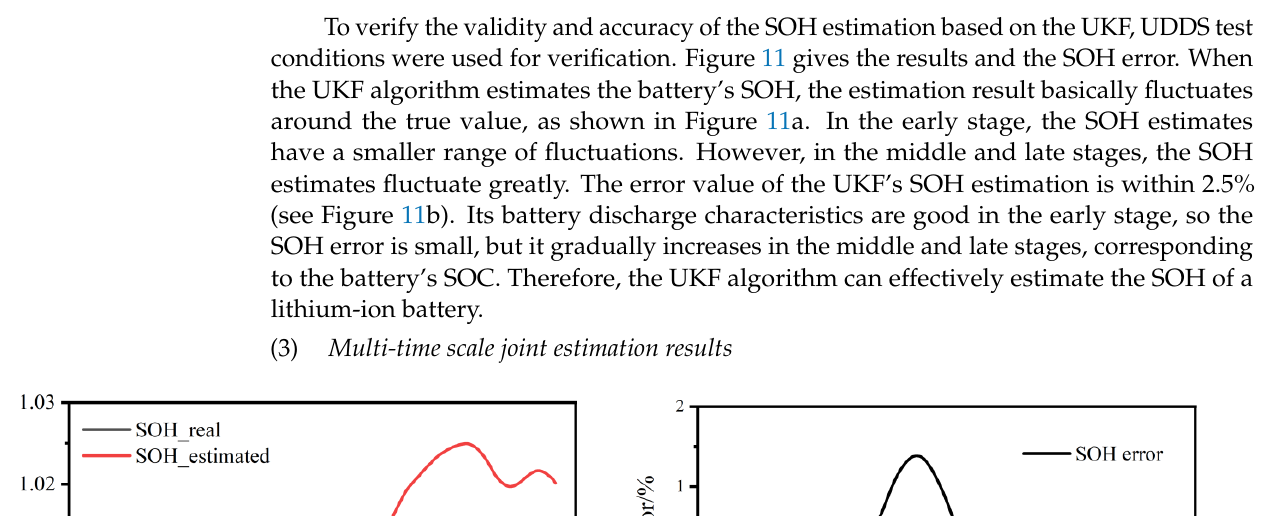
Figure 10. Result of SOC_discharge simulation based on different algorithms. ( a ) SOC_discharge estimation based on the UKPF, PF and UKF algorithms; ( b ) SOC_discharge estimation error based on the UKPF, PF and UKF algorithms.